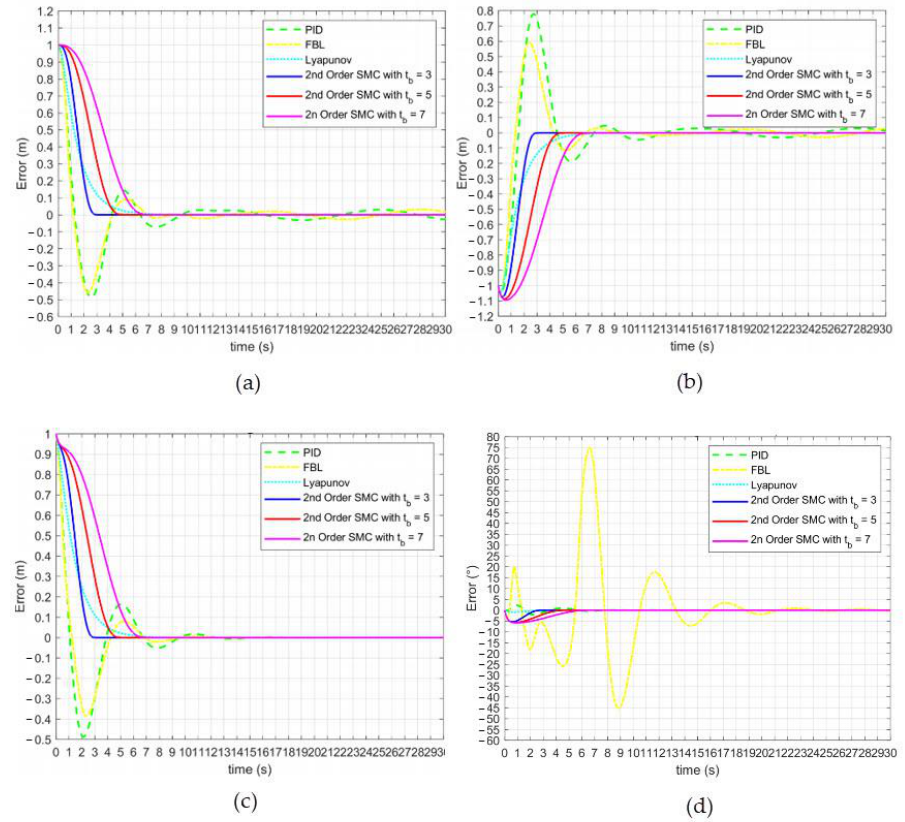
Figure 10. Error convergence for different controllers. ( a ) Surge error. ( b ) Sway error. ( c ) Heave error. ( d ) Yaw error.